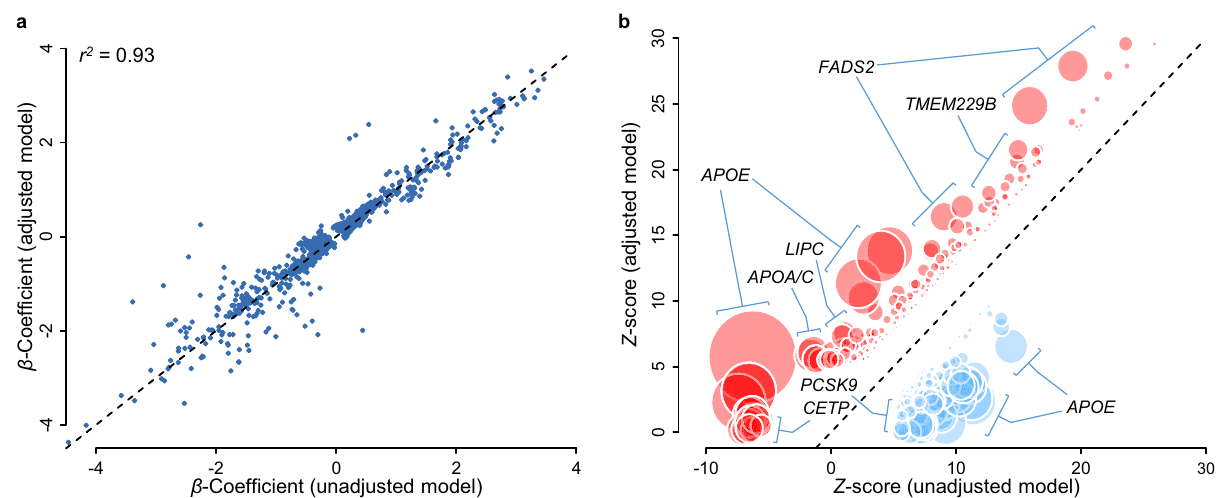
Fig. 3 Comparison of estimated lipidomic effect sizes between clinical lipid adjusted and unadjusted models. a Beta coef fi cients for independent unadjusted SNP-lipid associations ( x -axis) are plotted against clinical lipid-adjusted SNP-lipid associations ( y -axis). b Z -scores for unadjusted SNP-lipid associations ( x -axis) are plotted against clinical lipid-adjusted SNP-lipid associations ( y -axis). Z -scores for SNP associations reaching genome-wide signi fi cance ( P < 5 × 10 − 8 ) in either the clinical lipid adjusted or unadjusted models. Variant effect signs are fi xed so adjusted associations are positive. Variants showing greater (positive) associations in clinical lipid-adjusted analysis are shown in red, and variants showing reduced associations are shown in blue. Circle diameter is proportional of − log 10 ( P ) t -test of effect Associations validated in independent cohorts . For each lipid,